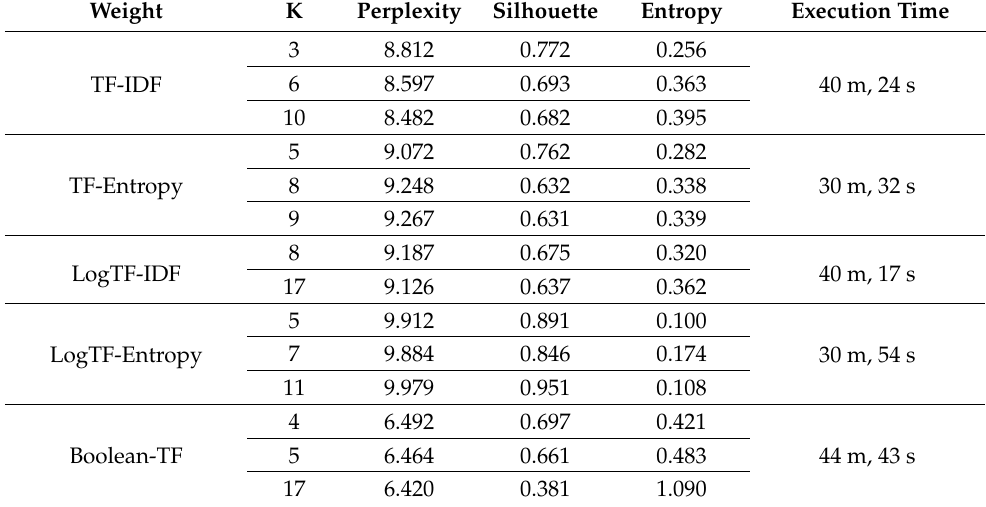
Table 5. Experimental results for D1 through the probabilistic approach. Weight K Perplexity Silhouette